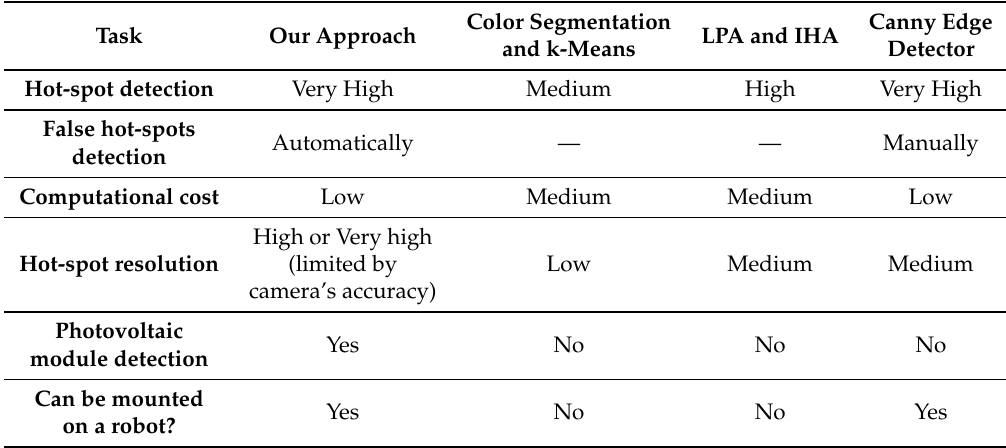
Table 9. Potential benefits of the proposed